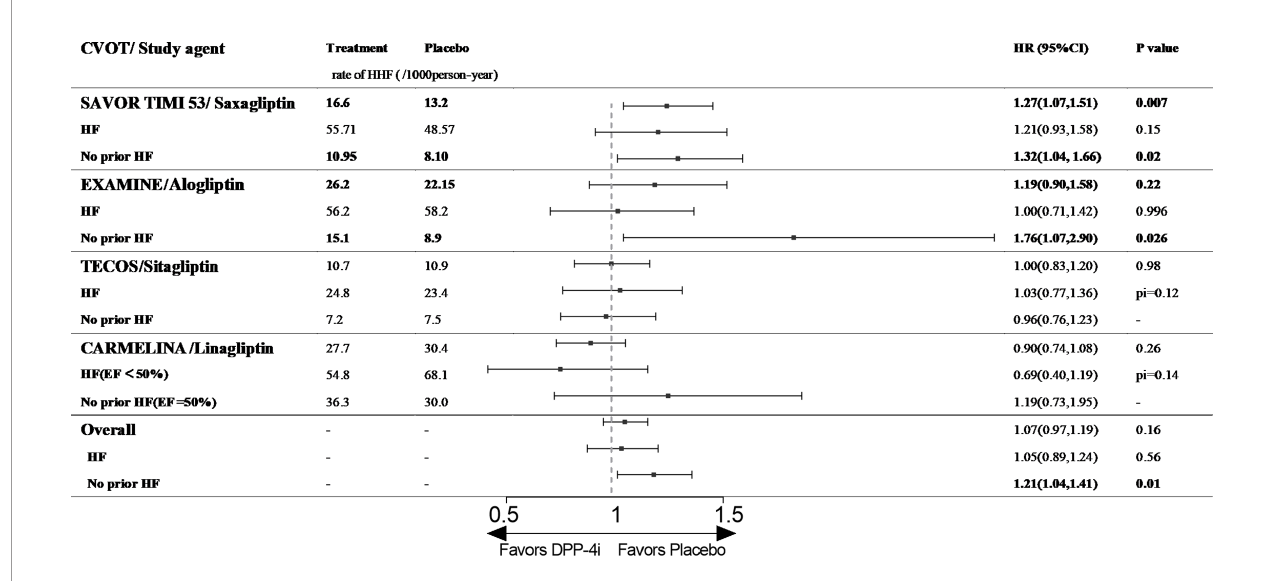
FIGURE 1 | The effect of DPP-4is on HHF in type 2 diabetic patients with and without history of HF. CVOT, cardiovascular outcome trial; HHF, hospitalization for heart failure; HF, heart failure; EF, ejection fraction; pi, p value of interaction; SAVOR TIMI 53, The Saxagliptin Assessment of Vascular Outcomes Recorded in Patients with Diabetes Mellitus (SAVOR) – Thrombolysis in Myocardial Infarction (TIMI) 53 trial; EXAMINE, Examination of Cardiovascular Outcomes with Alogliptin versus Standard of Care; TECOS, The Effect on Cardiovascular Outcomes in Type 2 Diabetes of Sitagliptin; CARMELINA, The Cardiovascular and Renal Microvascular Outcome Study with